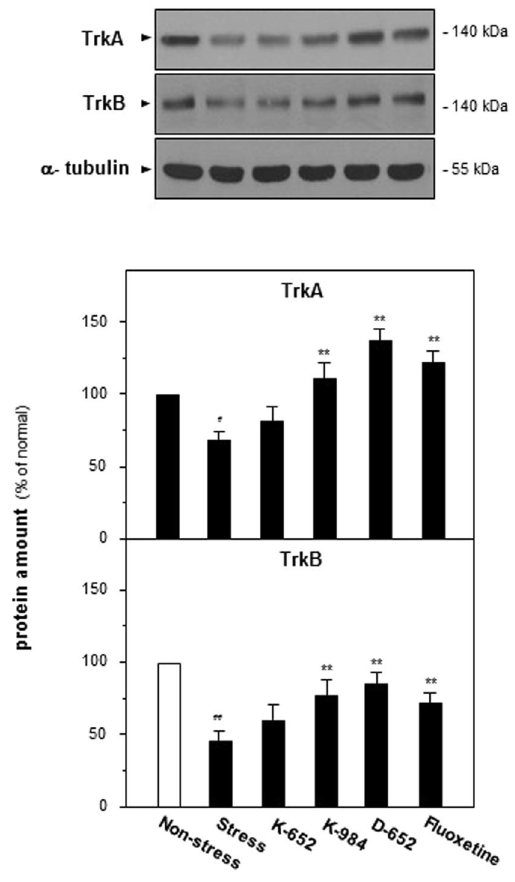
Figure 7. Effect of KXS series formulae treatment on the protein expressions of Trk receptors in hippocampus of CUMS-treated mice. The treatment of KXS series formulae and fluoxetine in the mice was same as that in Fig. 1. The hippocampus tissues were collected after one-week treatment and protein levels of TrkA and TrkB were analyzed. Comparisons between groups were carried out by a one-way ANOVA followed by a post-hoc Bonferroni test. Values are expressed in the percentage of non-stressed control group as Mean ± SEM (n = 8). # p < 0.05, ## p < 0.01 (compared with non-stressed group), * p < 0.05, ** p < 0.01 (compared with stressed